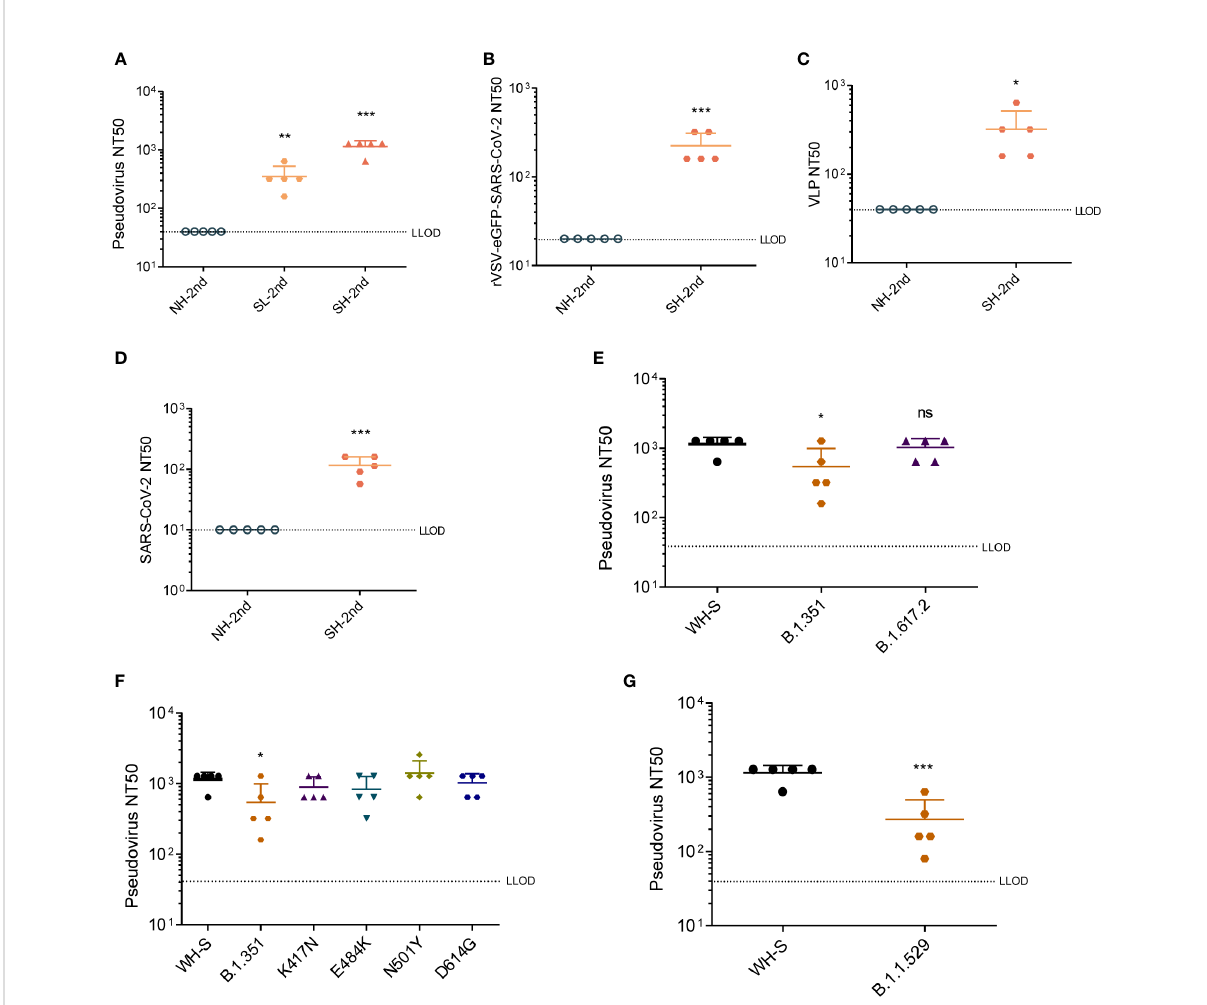
FIGURE 4 Neutralizing antibody responses in mice vaccinated by dTK-S. (A) Pseudovirus neutralization titers were determined for sera collected 2 weeks after dTK-S boost immunization. A 50% reduction relative to the uninfected control wells was shown as pseudovirus NT50. (B) Neutralization activities of the sera from the second dose of dTK-S vaccination against rVSV-eGFP-SARS-CoV-2. (C) VLP neutralization activities of sera from the second dose of dTK-S vaccination. (D) Neutralization activities of the sera from the second dose of dTK-S vaccination against SARS-CoV-2. (E) Neutralization activities of sera from the second dose of dTK-S vaccination for pseudoviruses carrying spike proteins of the SARS-CoV-2 Wuhan strain (WH-S) B.1.351 or B.1.617.2. (F) Neutralization activities of sera from the immunized mice for pseudoviruses carrying spike protein of the SARS-CoV-2 Wuhan strain (WH-S), B.1.351, or carrying single mutations K417N, E484K, N501Y, or D614G. (G) Neutralization activities of sera from the second dose of dTK-S vaccination for pseudoviruses carrying spike proteins of the SARS-CoV-2 Wuhan strain (WH-S) or B.1.1.529. Dotted lines indicate the lower limit of detection (LLOD). Animals with a response at or below the LLOD were put on LLOD. Statistical differences as determined by Student ’ s t -tests are indicated by asterisks; * p < 0.05, ** p < 0.01; *** p < 0.001. dTK-S, vaccinia virus-expressing spike protein; VLP, virus-like